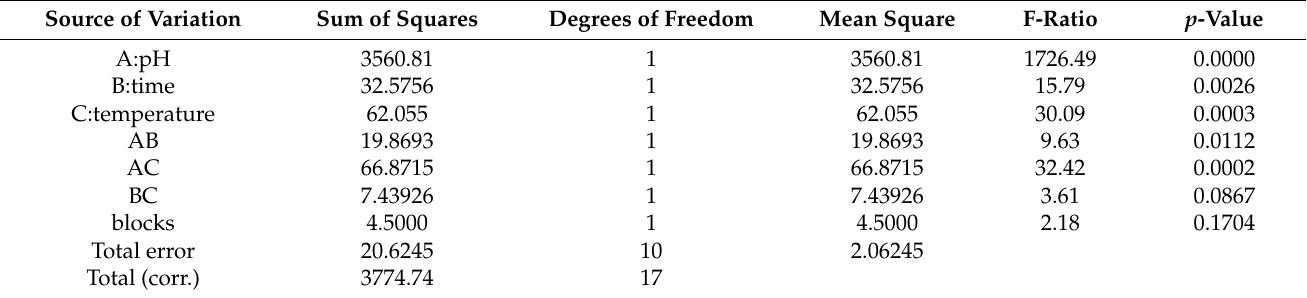
Table A2. Analysis of variance (ANOVA) corresponding to the 2 3 factorial design for King